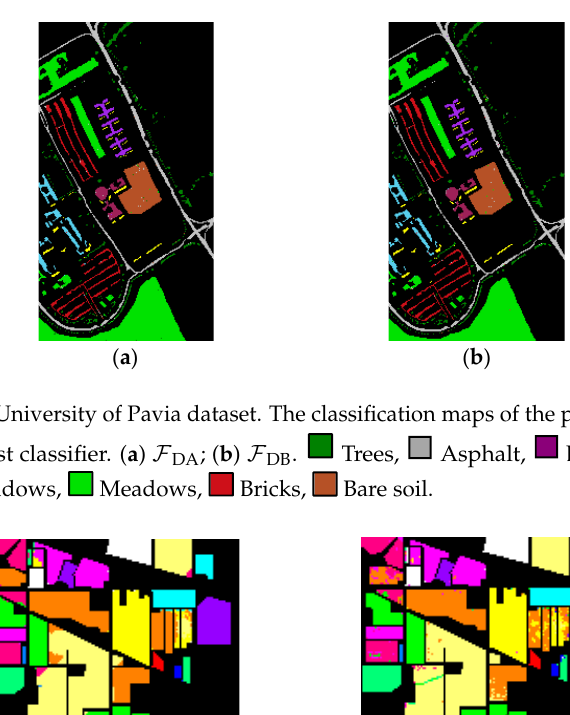
Number of Samples